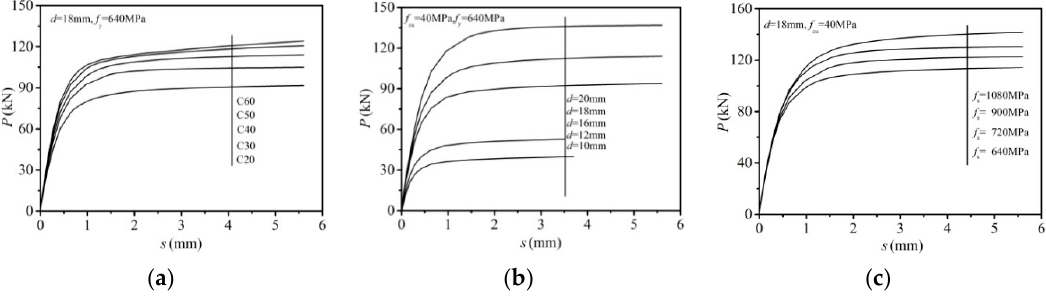
Figure 14. Load-slip curves of bolt shear connector: ( a ) concrete strength; ( b ) bolt diameter; ( c ) yield strength of bolt.